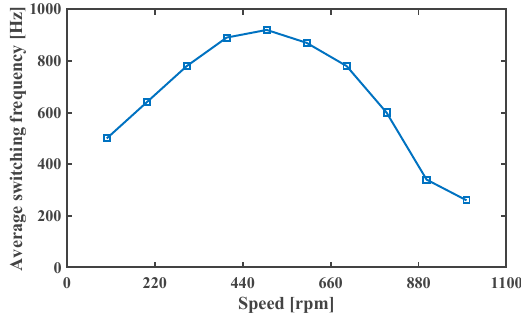
Figure 7. Average switching frequency as a function of the speed.